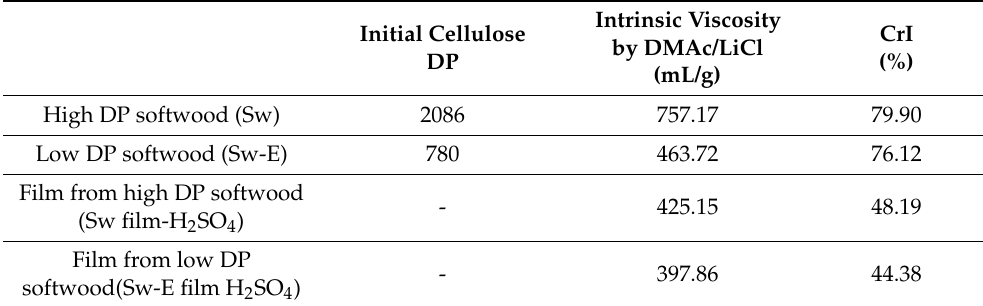
Table 5. Crystallinity index and intrinsic viscosity of the high and low DP cellulose films prepared from softwood BKP fibers by using sulfuric